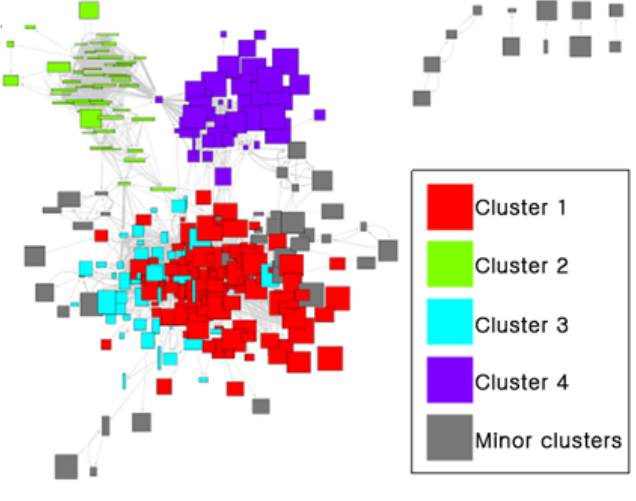
Figure 6. Four major clusters of the network.